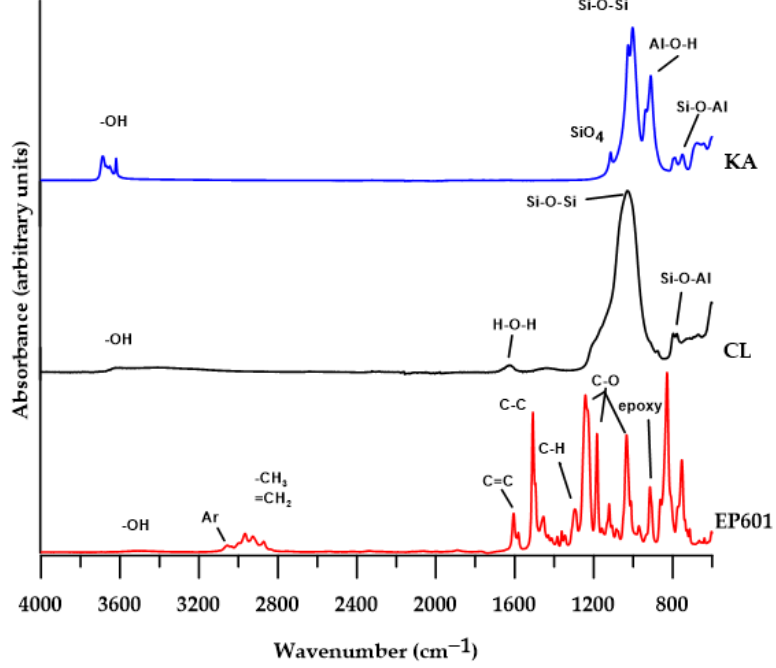
Figure 5. ATR/FTIR spectra of pure EP601 and fillers: CL and KA. 192 The ATR/FTIR spectra of KA show characteristic absorption bands associated with 193 vibrations: 3616–3686 cm − 1 —vibrations of OH groups in the crystal structure, 1114 cm − 1 — 194 stretching vibrations of the tetragonal structure of SiO 4 ; 1026 and 1003 cm − 1 —stretching 195 vibrations of Si-O-Si; 911 cm − 1 —Al-O-H bending vibrations of the Al 2 OH group; 788, 750 196 and 676 cm − 1 —stretching vibrations of Si-O, Si-O-Al as well as Al-O-H [29]. 197 The ATR/FTIR CL spectrum shows that there is water in its structure (absorption 198 bands at 3398 and 3615 cm − 1 characteristic of the OH group vibrations and a band at 199 1620 cm − 1 corresponding to the H-O-H stretching vibrations of the water molecule). In 200 addition, the spectrum shows the absorption bands at 1029 cm − 1 —stretching vibrations of 201 Si-O and Al-O, and the absorption bands at 797, 779 cm − 1 —stretching vibrations of Si-O 202 and Si-O-Al [30]. 203 The ATR/FTIR spectrum of pure EP601 shows the following characteristic absorption 204 bands: at 3500 cm − 1 (OH stretching vibrations); at 3057 and 3027 cm − 1 (C-H stretching 205 vibrations of the aromatic ring, asymmetric and symmetric, respectively); 2967cm − 1 (asym- 206 metric C-H stretching vibrations of the CH 3 group); 2927cm − 1 (asymmetric stretching 207 vibrations C-H of the CH 2 group); 2872cm − 1 (symmetric C-H stretching vibrations of CH 2 208 and CH 3 groups); 1606, 1582, 1496 and 1455 cm − 1 (C-C and C=C aromatic ring stretching 209 vibrations); 1296 cm − 1 (asymmetric C-H bending vibration in CH 2 ); 1242 and 1033 cm − 1 (C- 210 O aromatic stretching vibrations, asymmetric and symmetric, respectively); 1183 cm − 1 (C- 211 O aliphatic stretching vibrations); 971, 915 cm − 1 (characteristic vibrations of the epoxy 212 ring); 828 cm − 1 (deformation vibrations of the p-substituted benzene ring) [31]. 213